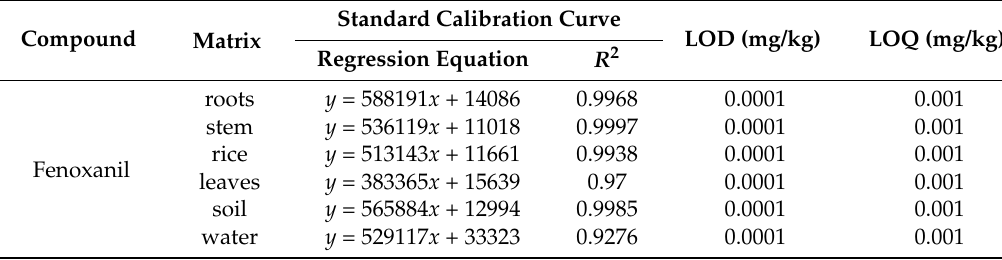
Table 2. The standard calibration curve ( R 2 ), limit of detection (LOD), and limit of quantification (LOQ) of Fenoxanil in different matrices.